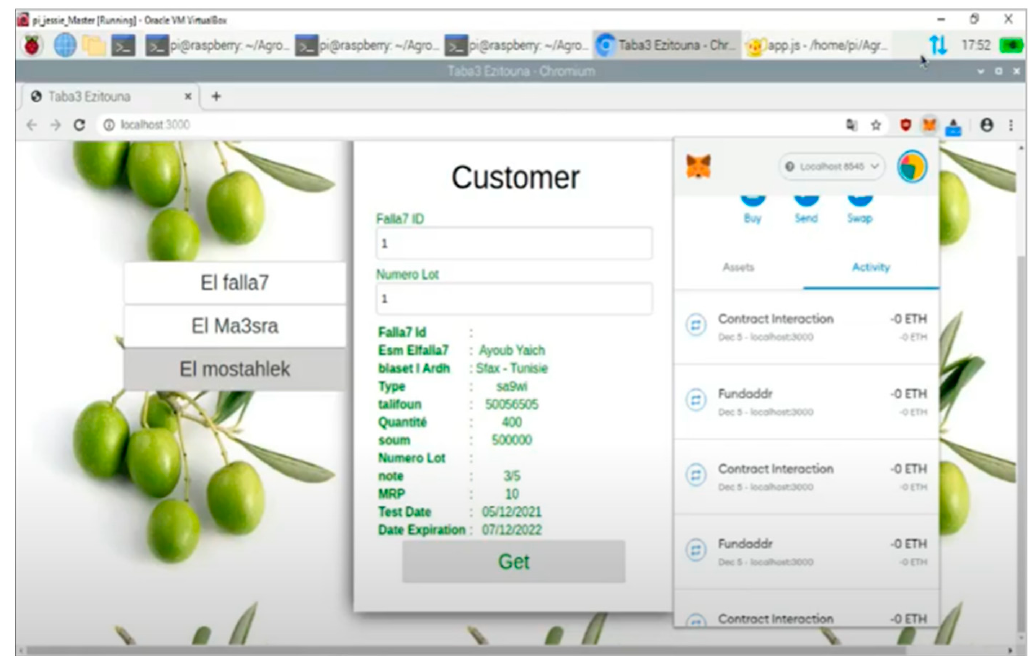
Figure 14. Monitoring and securing production: customer interface.